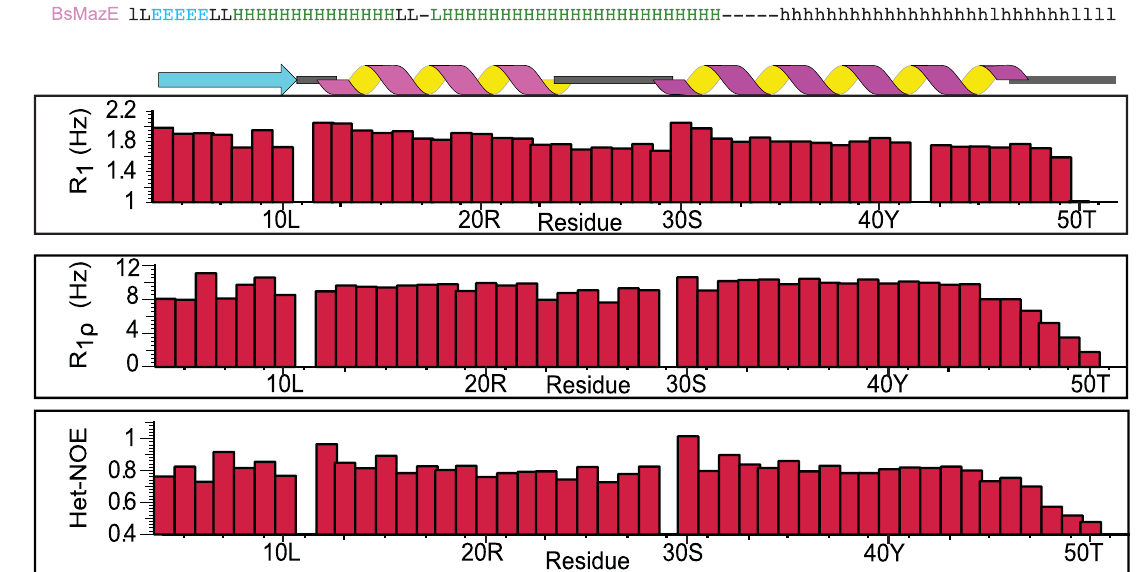
accompanied titration with non-cognate mazEF9 operator DNA for which K d could not be determined (Fig. 6c and d), indicating that the antitoxin binding is speci fi c to its cognate operator DNA. The results of the NMR and ITC titration studies unequivocally establish that MazE6 regulate its cognate operon via a highly speci fi c and strong